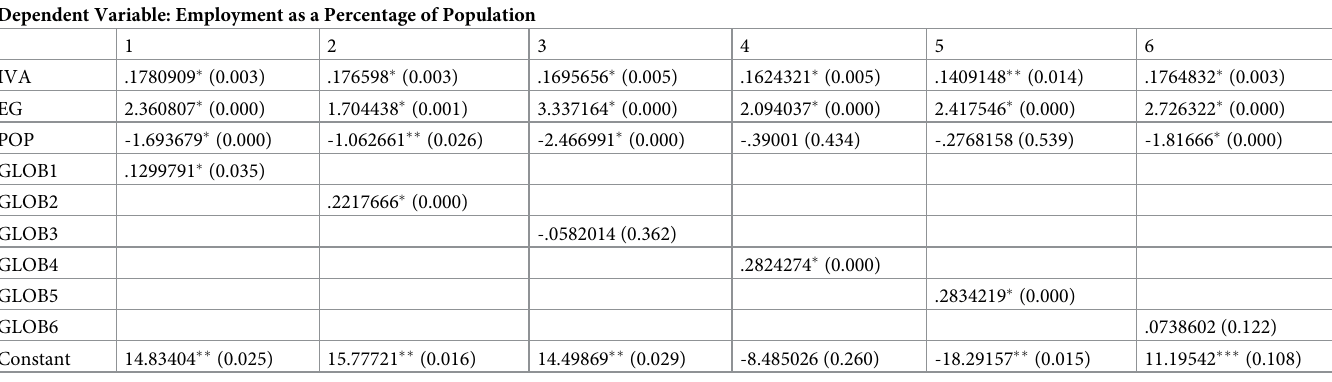
Table 8. Direct impact of globalization on employment (GLS).